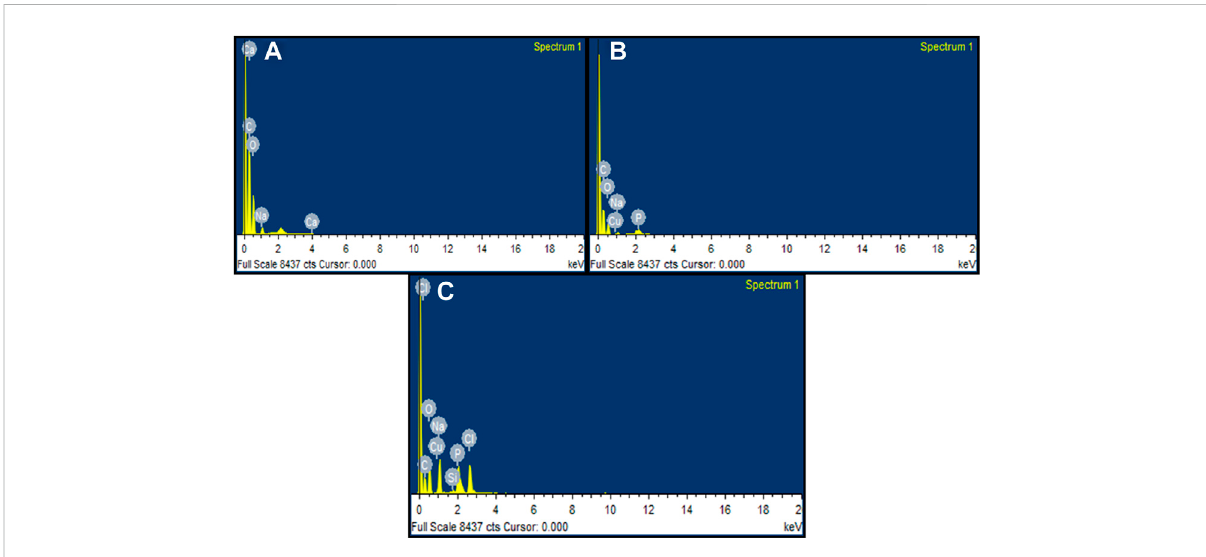
FIGURE 13 EDXanalysisoffungalhyphae: (A) control, (B) EDXspectraofM - CuONP-treatedfungushyphae,and (C) EDXspectraofmyceliatreatedwithC - CuO